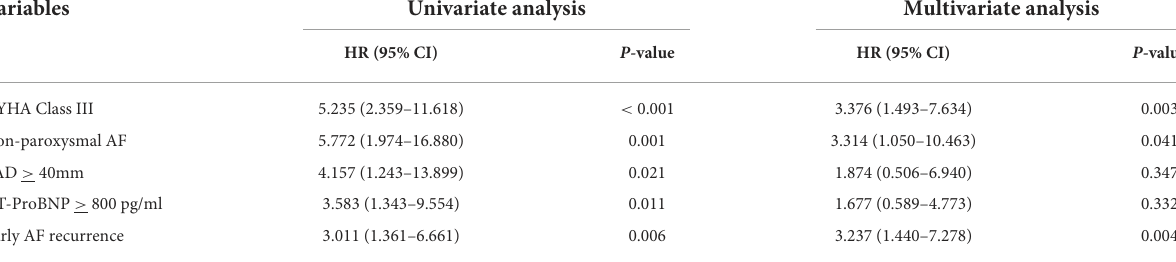
TABLE 3 Univariate and multivariate analyses for risk factors of AF recurrence after multiple procedures.